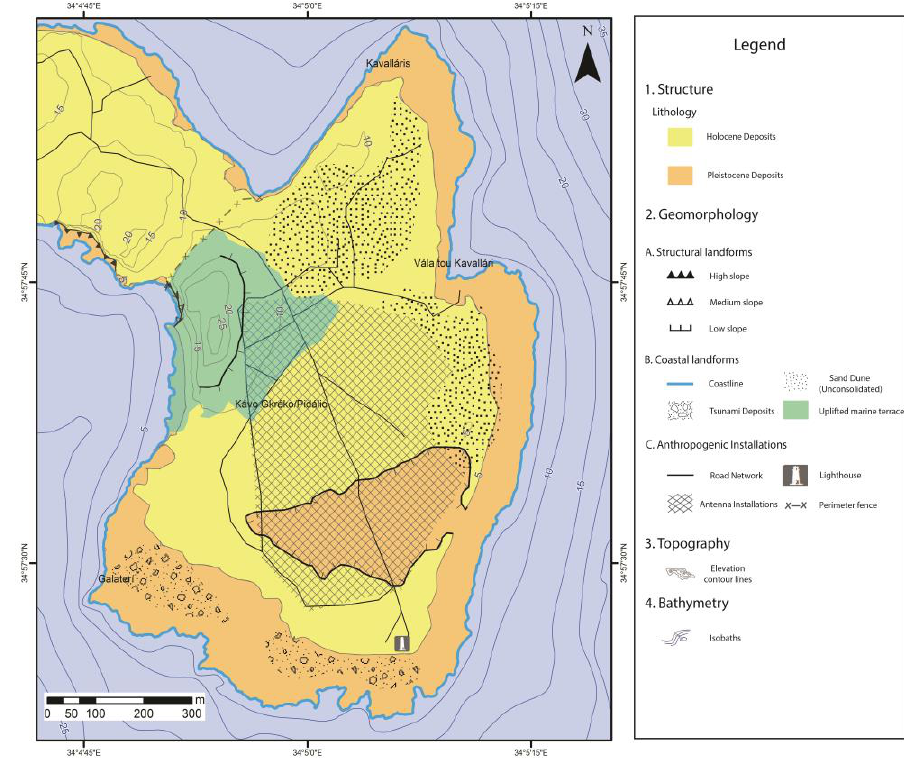
Figure 2. Geomorphological map of Cape Greco.